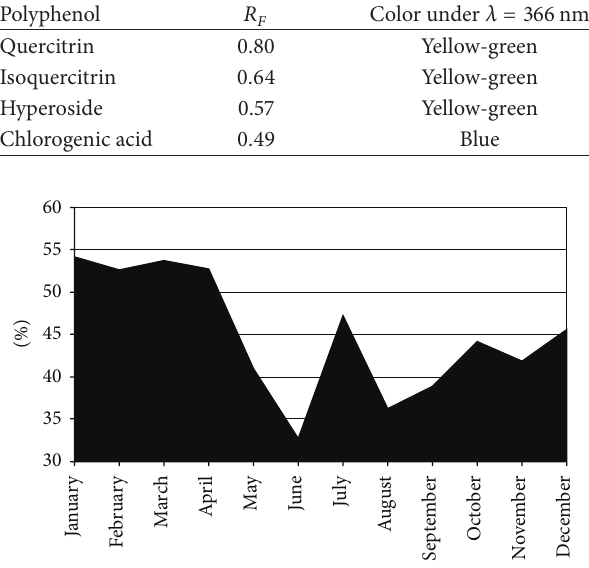
Figure 1: Variation of antioxidant activity expressed in percentages during the